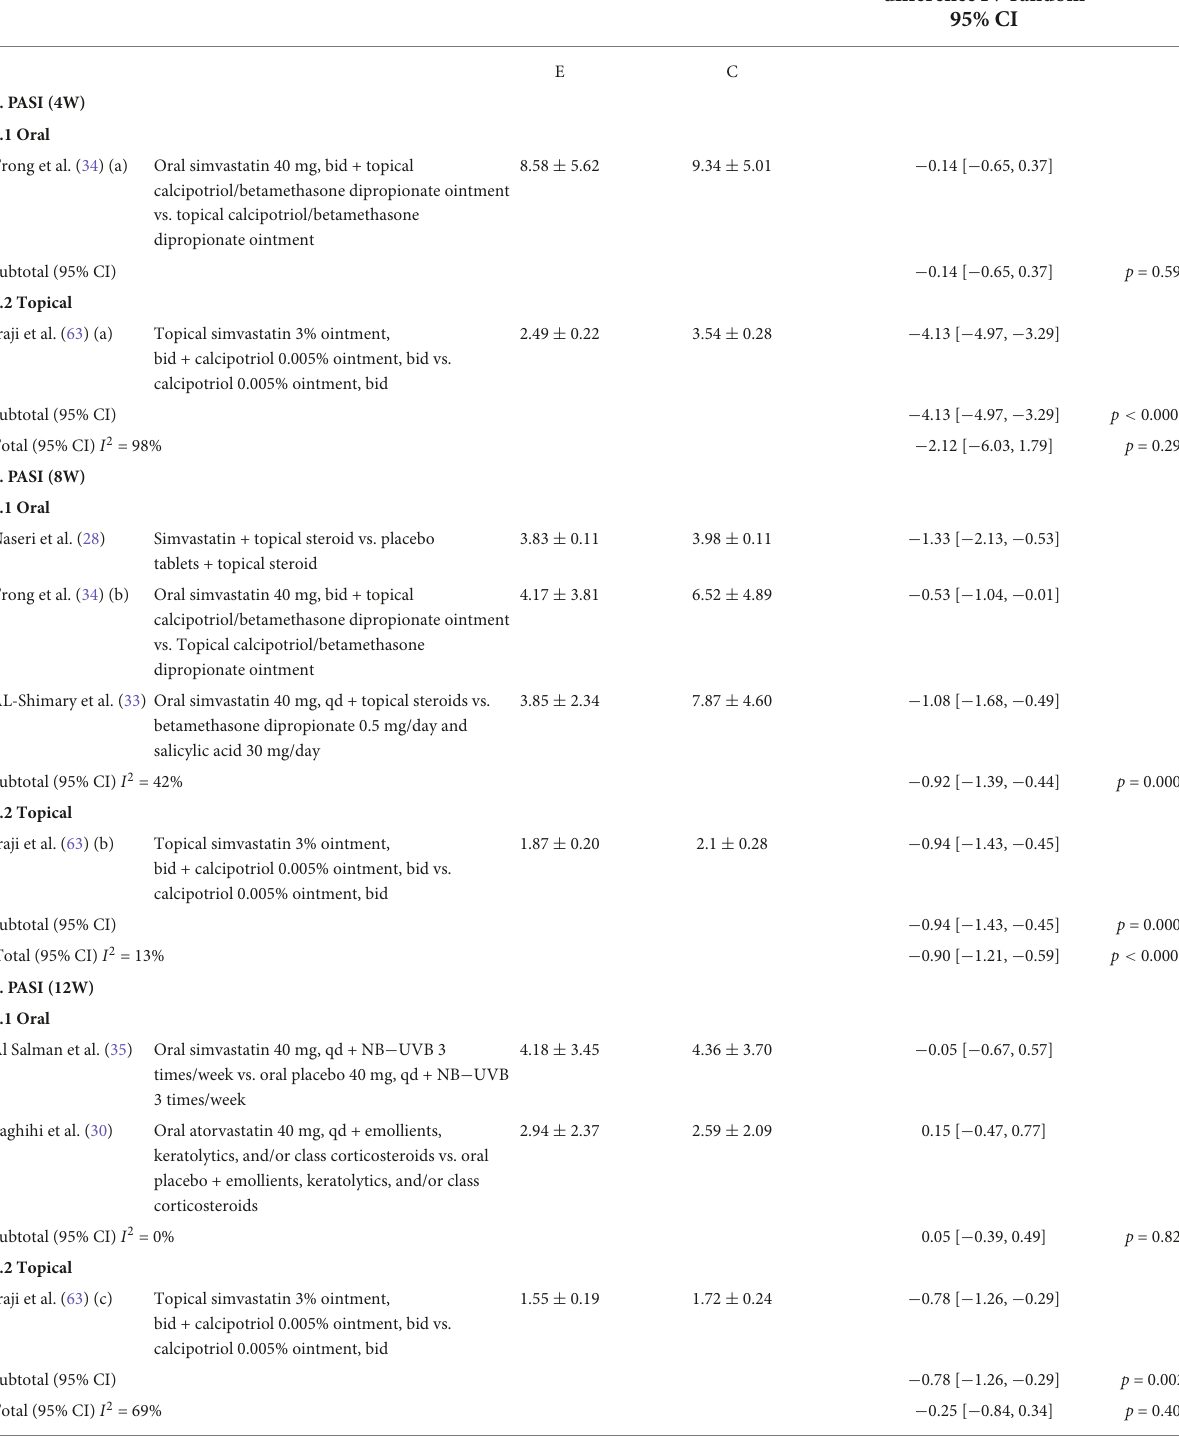
TABLE 1 Subgroup analysis of PASI scores in randomized controlled